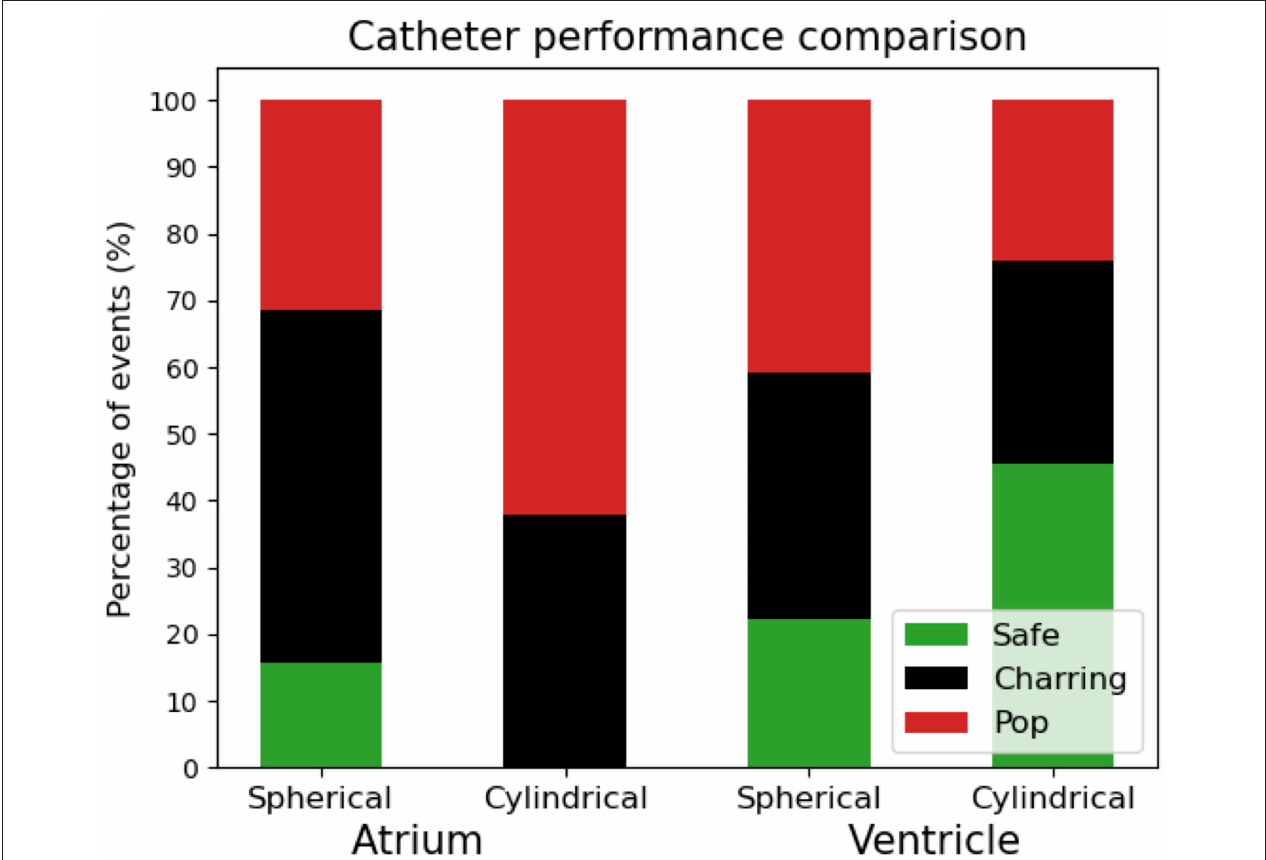
FIGURE 3 | Overall safety comparison of the two different catheter tip